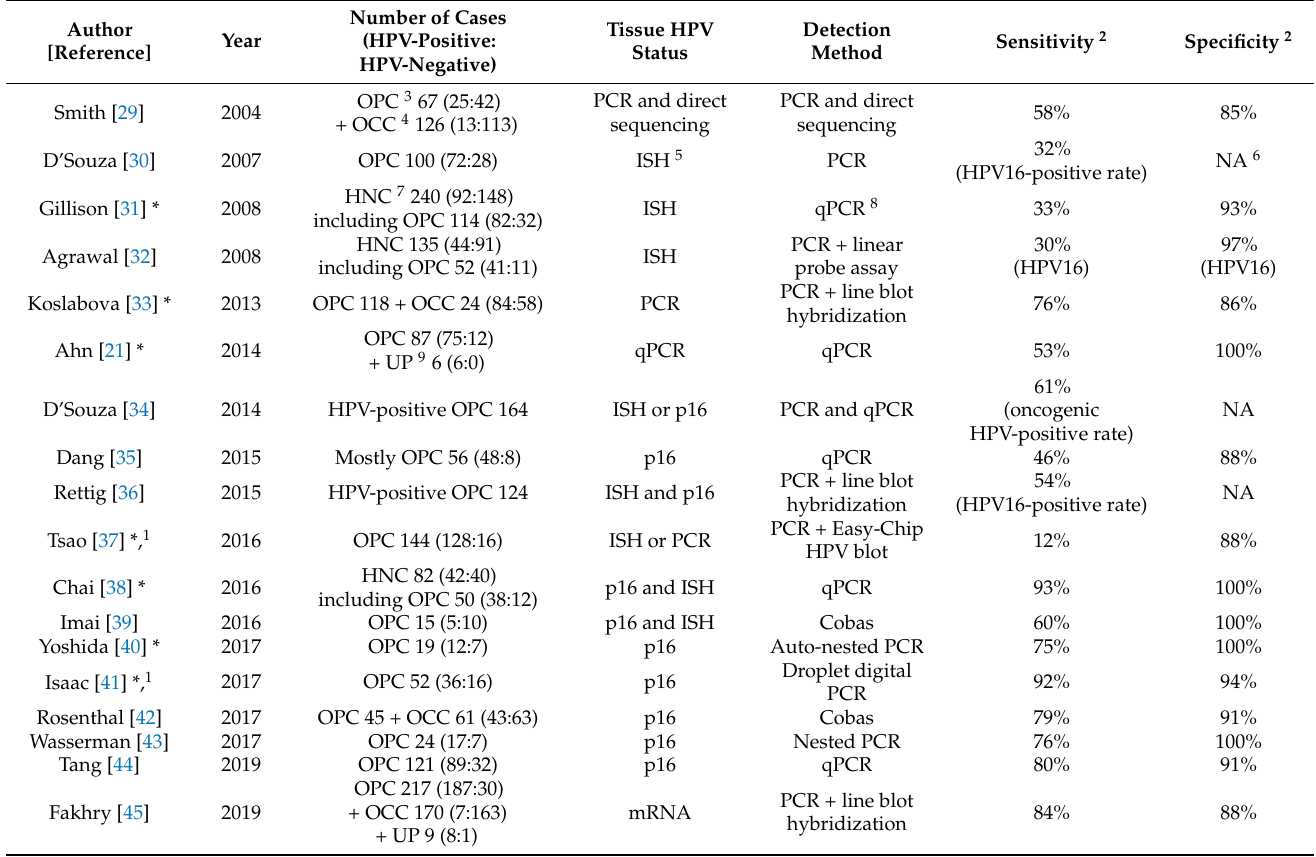
Table 3. HPV DNA detection in pre-treatment oral rinse in oropharyngeal cancer patients.